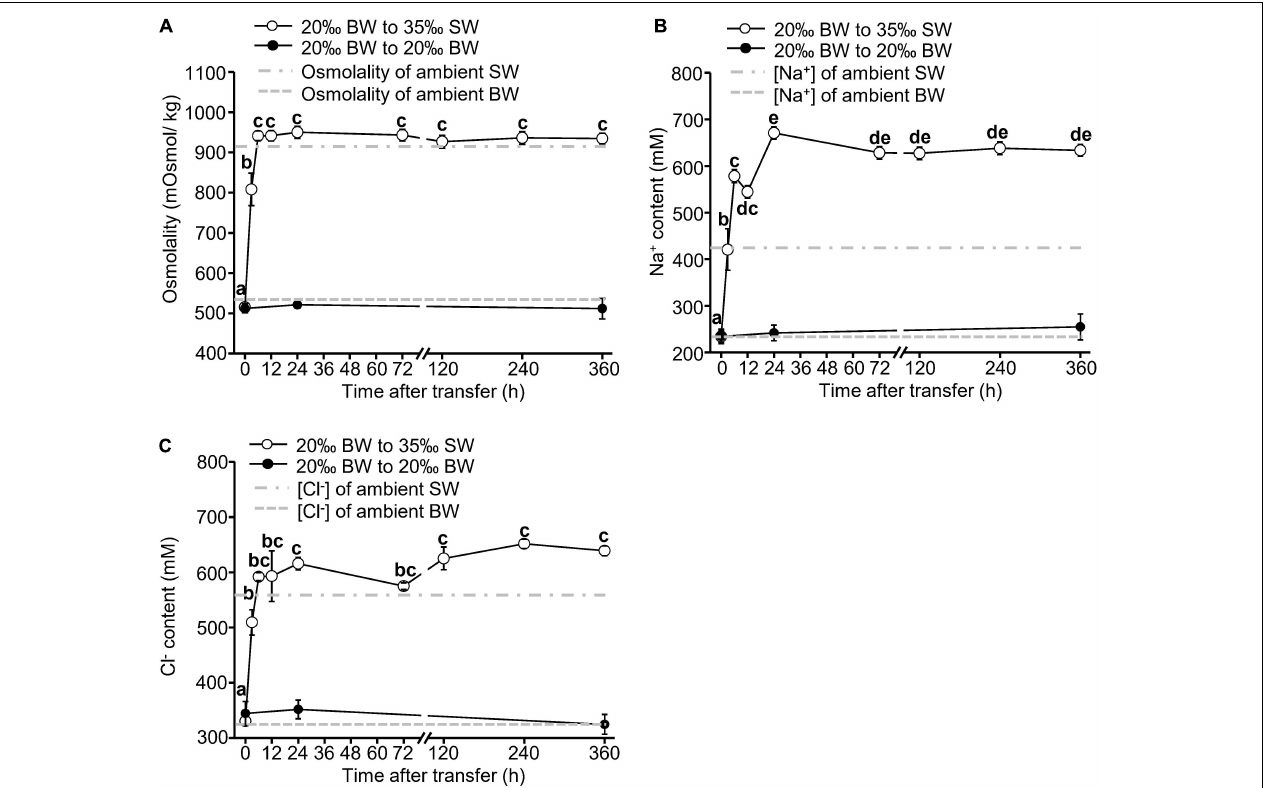
FIGURE 1 | Changes in osmolality (A) , sodium (B) , and chloride (C) concentrations of the hemolymph of Asian hard clams transferred directly from